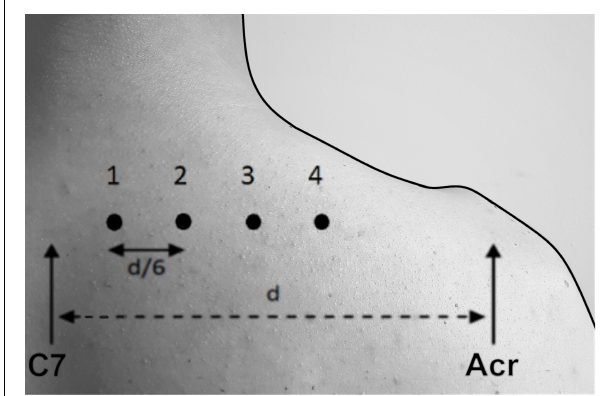
FIGURE 1 | Location of the four measurement points marked on the skin overlying the upper trapezius muscle for the assessment of muscle dynamic stiffness measured by myotonometry, elastic modulus measured by shear-wave elastography and thickness measured by ultrasonography C7, 7th cervical vertebrae spinous process; Acr., acromion; “d”, the distance between C7 spinous process and